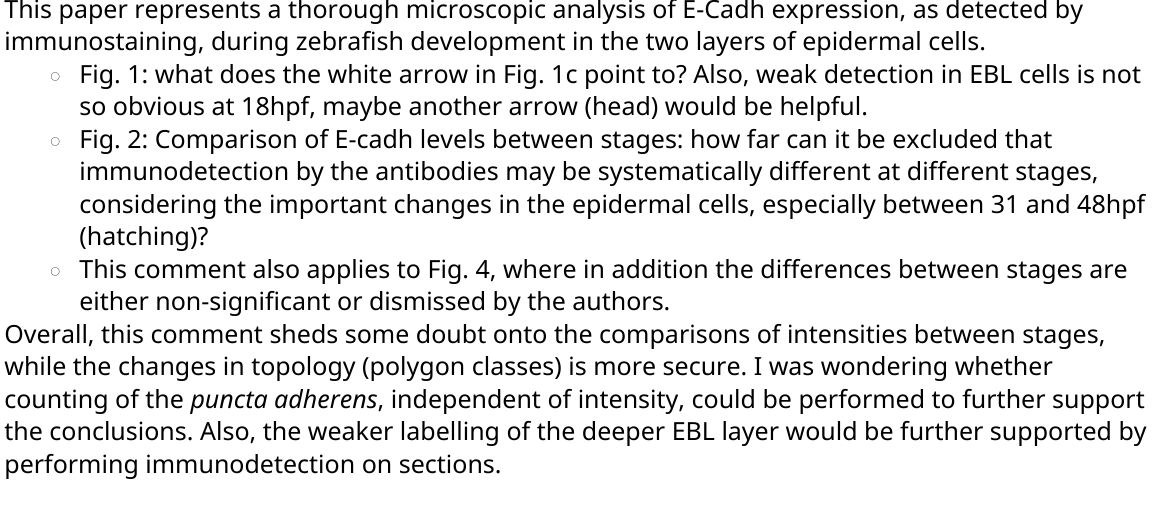
Fig. 1: what does the white arrow in Fig. 1c point to? Also, weak detection in EBL cells is not so obvious at 18hpf, maybe another arrow (head) would be helpful. Fig. 2: Comparison of E-cadh levels between stages: how far can it be excluded that immunodetection by the antibodies may be systematically different at different stages, considering the important changes in the epidermal cells, especially between 31 and 48hpf